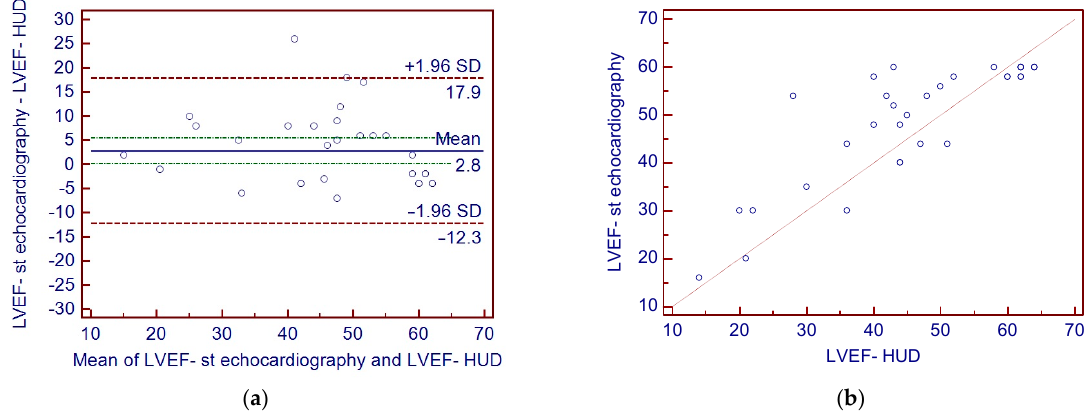
Figure 3. LVivo (HUD) and reference LVEF measurements comparison; ( a ) Bland–Altman plots of the LVEF assessed with LVivo software and reference method; ( b ) scatter diagram correlation.